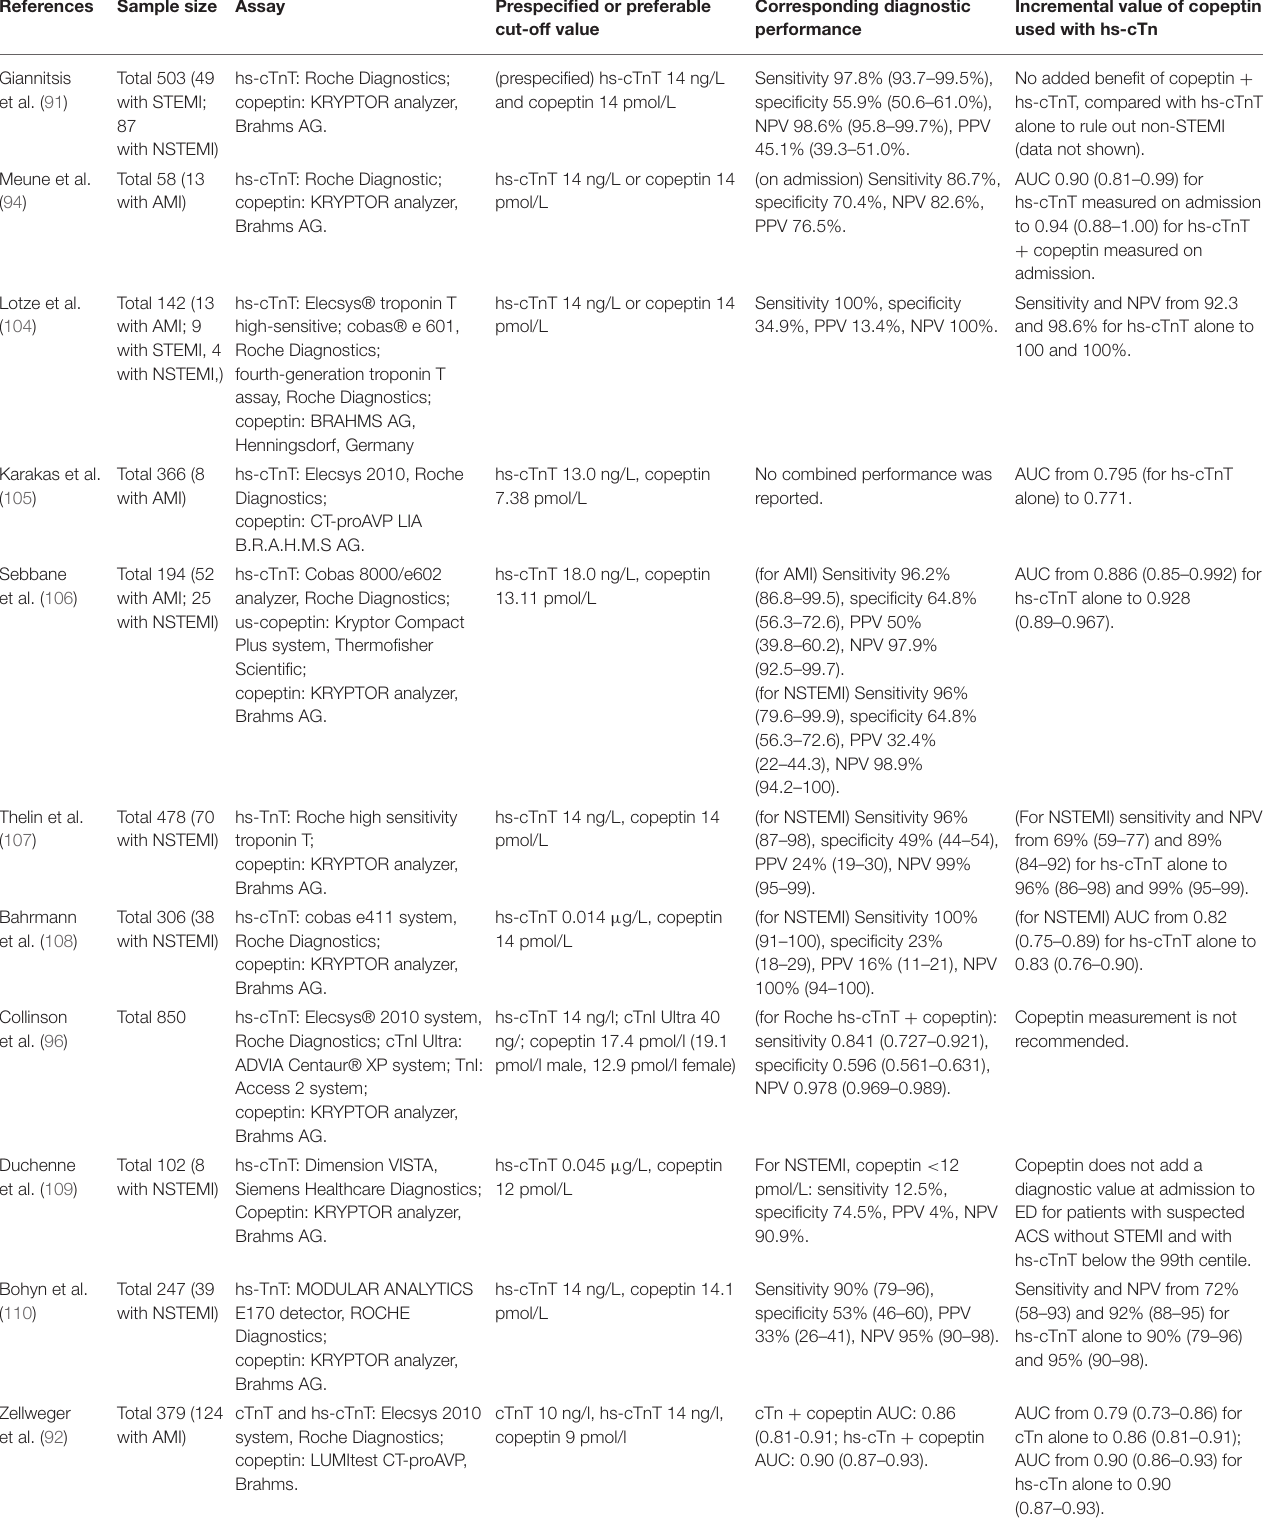
TABLE 3 | Articles about the diagnostic performance of hs-cTn combined with copeptin measurement in the rule-out of AMI. References Sample size Assay Prespecified or preferable